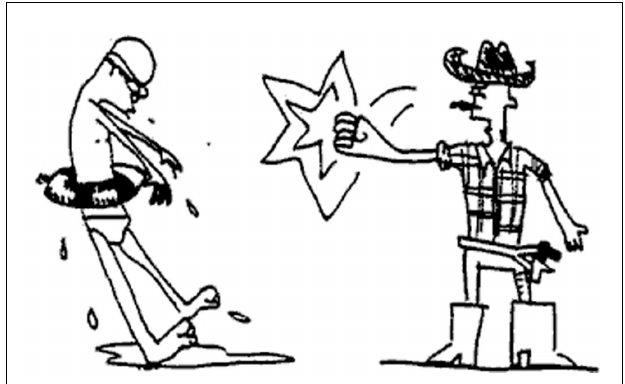
FIGURE 1 |Target-event